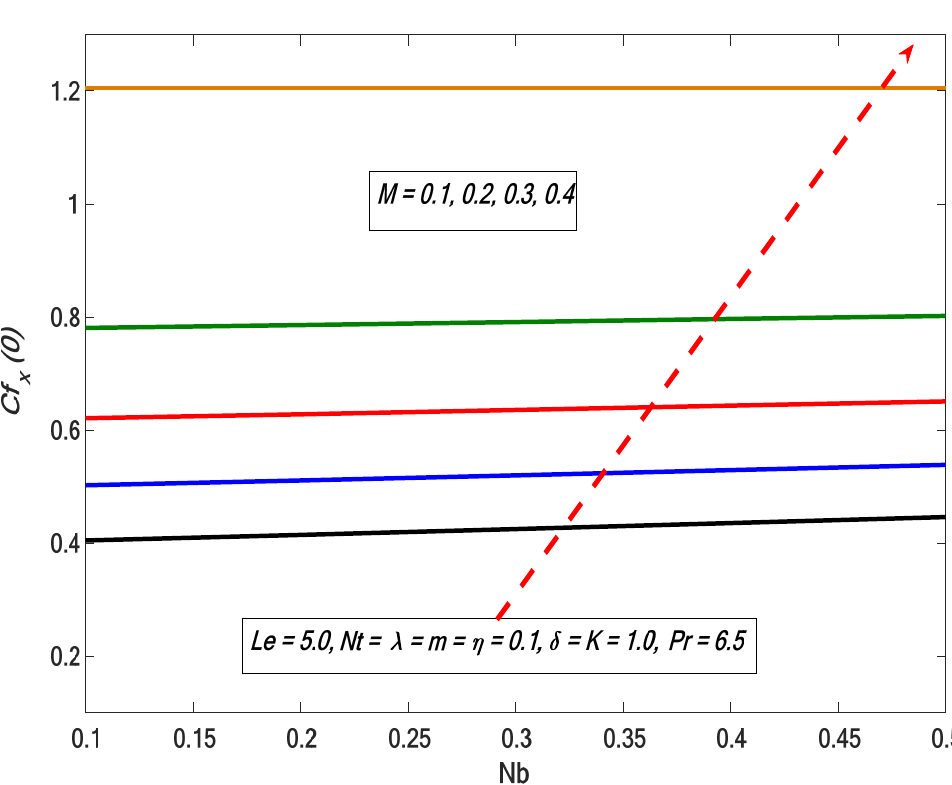
Figure 12. C fx ( 0 ) for various values of M and Nb Figure 12. 𝐶 (cid:3033)(cid:3051) (cid:4666)0(cid:4667) for various values of M and 𝑁𝑏.